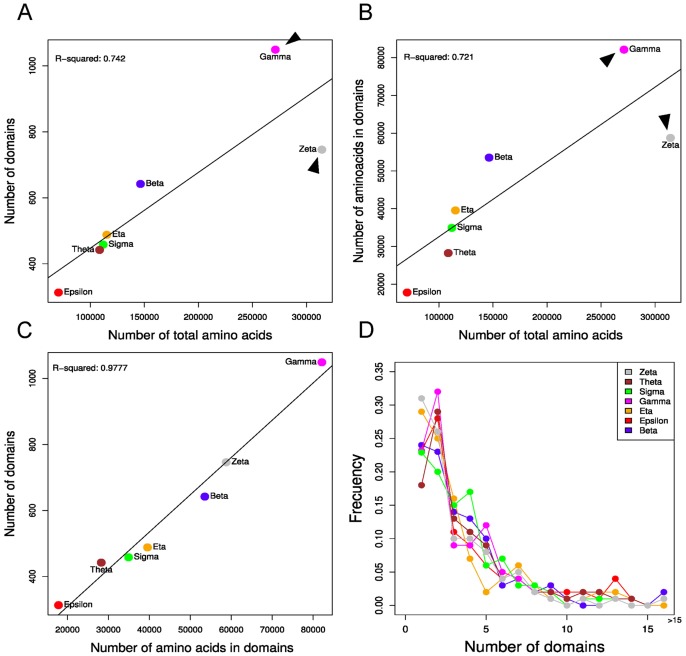
Domain abundance of 14-3-3 isoforms’ partners.A) Number of domains and B) number of amino acids in domains vs number of total amino acids. C) Number of domains vs number of amino acids in domains. D) Frequency of partners with x numbers of domains within each 14-3-3 isoform network. The colors for each 14-3-3 isoform are maintained throughout the different figures.